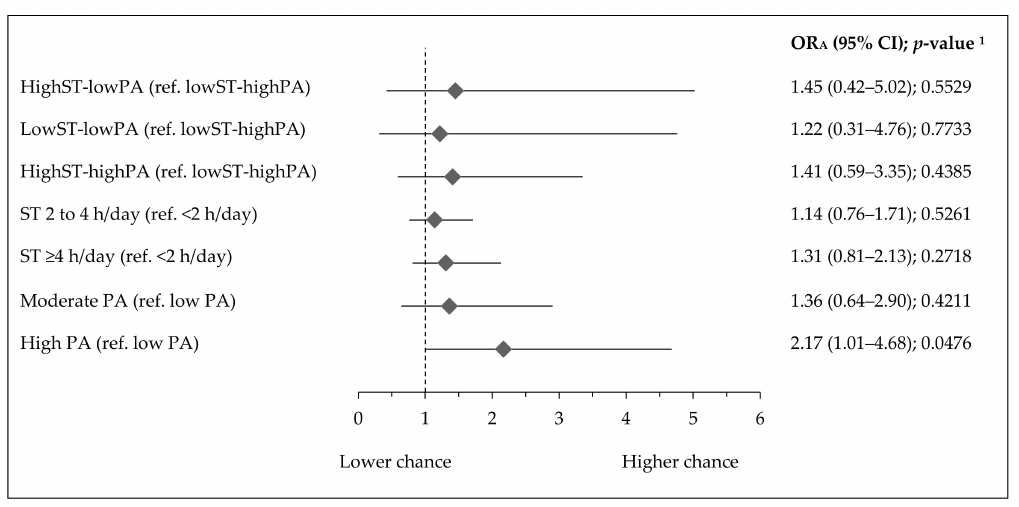
Figure 3. Association of activity–inactivity patterns, ST, and PA with central obesity in Polish teenagers (ref. lack of central obesity). Notes: ST—screen time; PA—physical activity; central obesity identified as waist-to-height ratio ≥ 0.5; lack of central obesity identified as waist-to-height ratio < 0.5 [36]; OR A —odds ratio adjusted for gender, age (years), residence (categorical variable), Family A ffl uence Scale (points) and Nutrition Knowledge Score (points); 95% CI—confidence interval; 1 Wald test significance level.